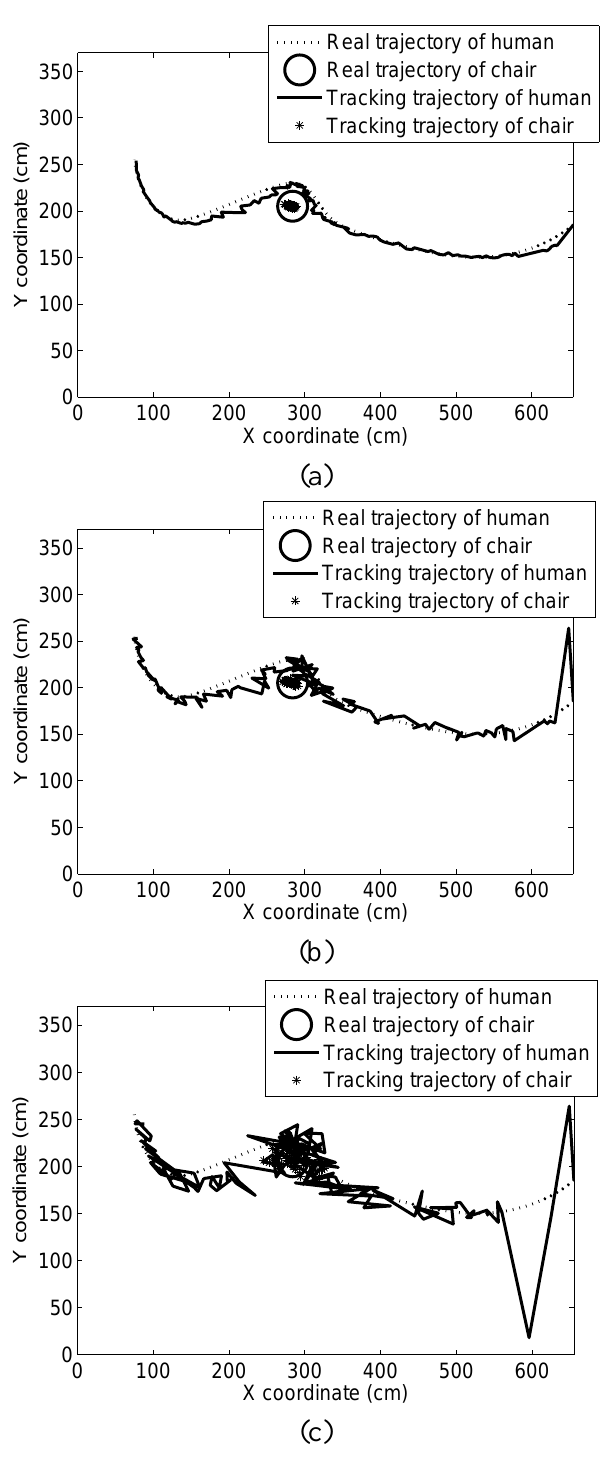
Figure 7. Multi-target tracking results of (a) distributed P2P framework, (b) distributed client/server framework and (c) centralized client/server